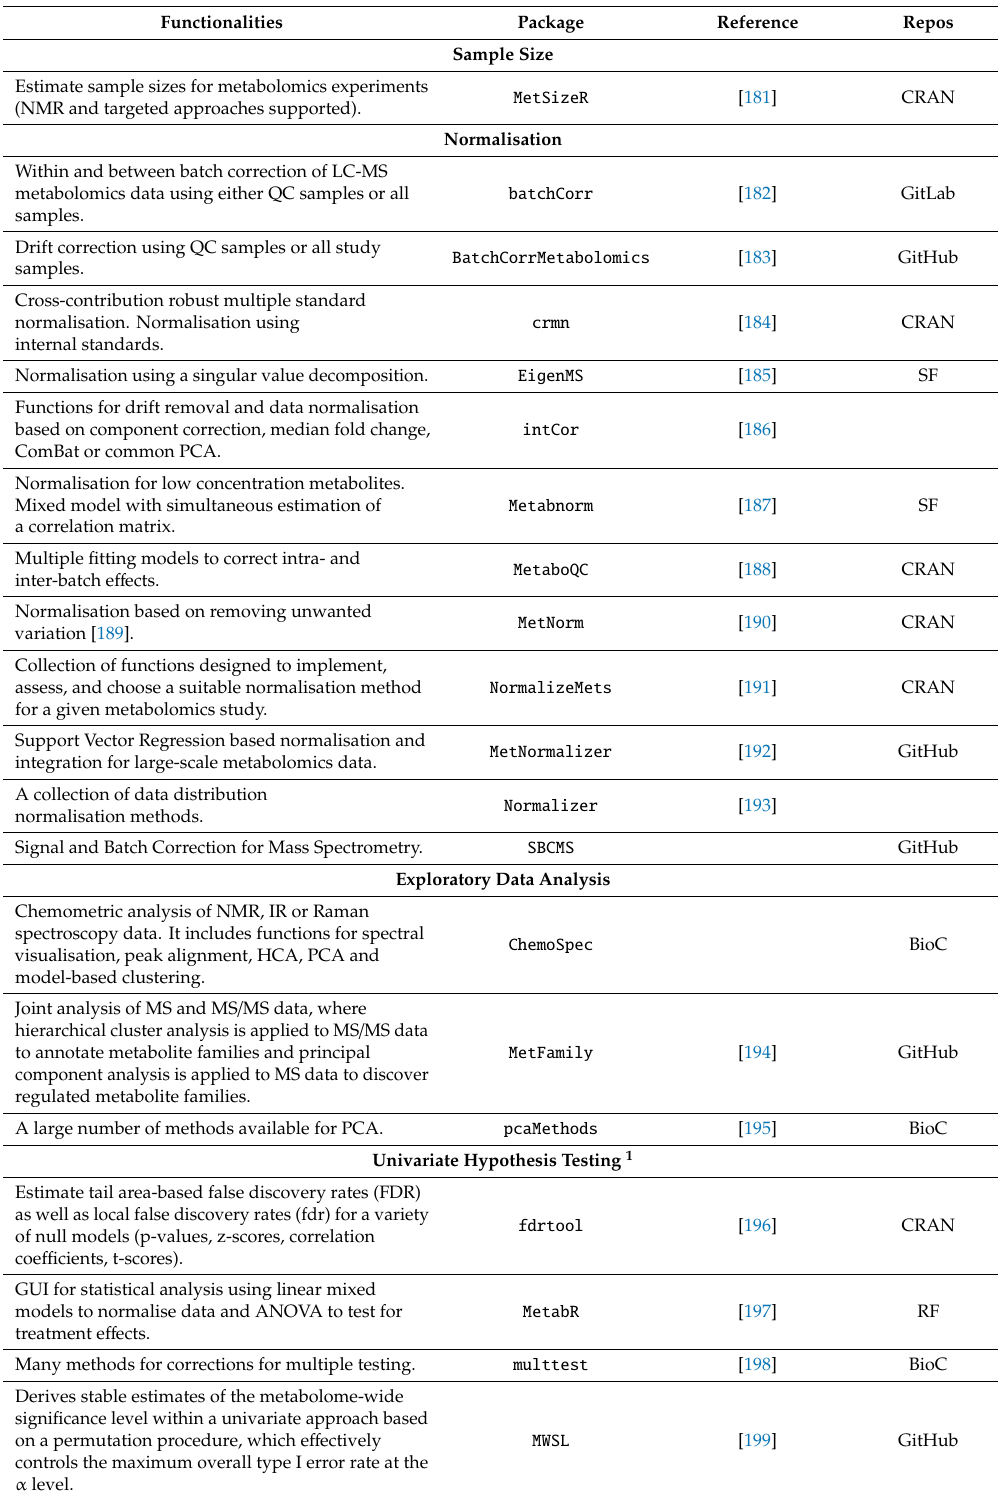
Table 6. R packages for statistical analysis of metabolomics